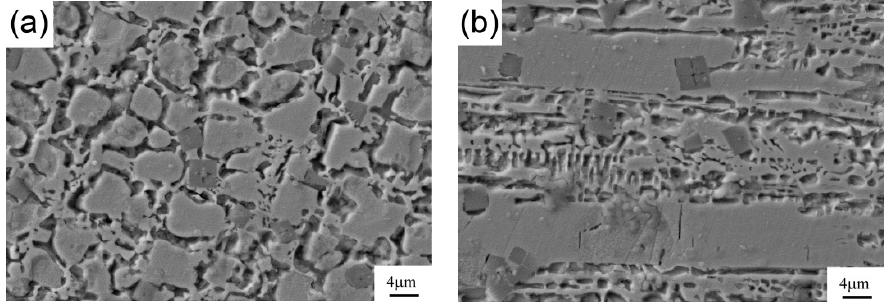
Figure 4. SEM images of borides of the hardfacing layer with 6.85% B contents: ( a ) surface; ( b ) the top of the cross-sectional view.